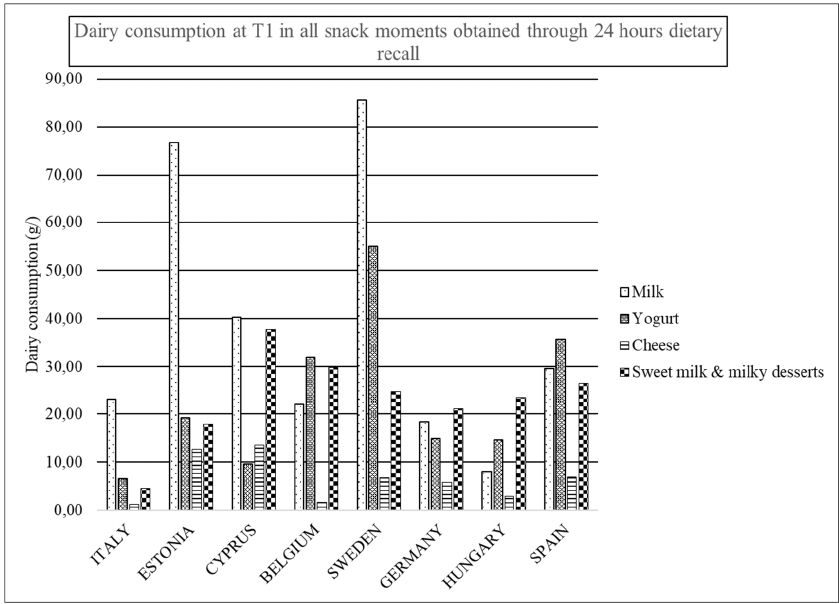
Figure 3. Dairy consumption at T1 in all snack moments obtained through 24 HDR.